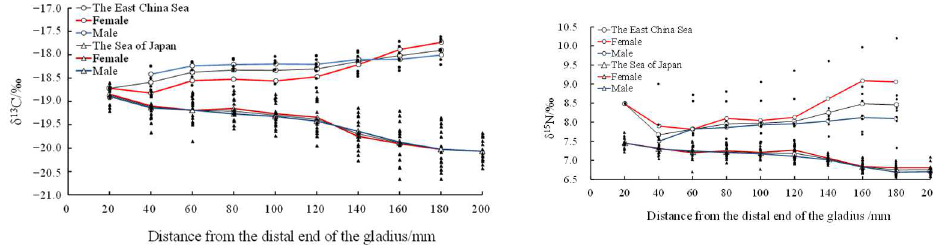
Figure 8. Relationship between average δ 13 C‰ and δ 15 N‰ values and the growth of the proostracum of T. pacificus collected in the East China Sea and the Sea of Japan. (Black line represents males, and red line represents females.)